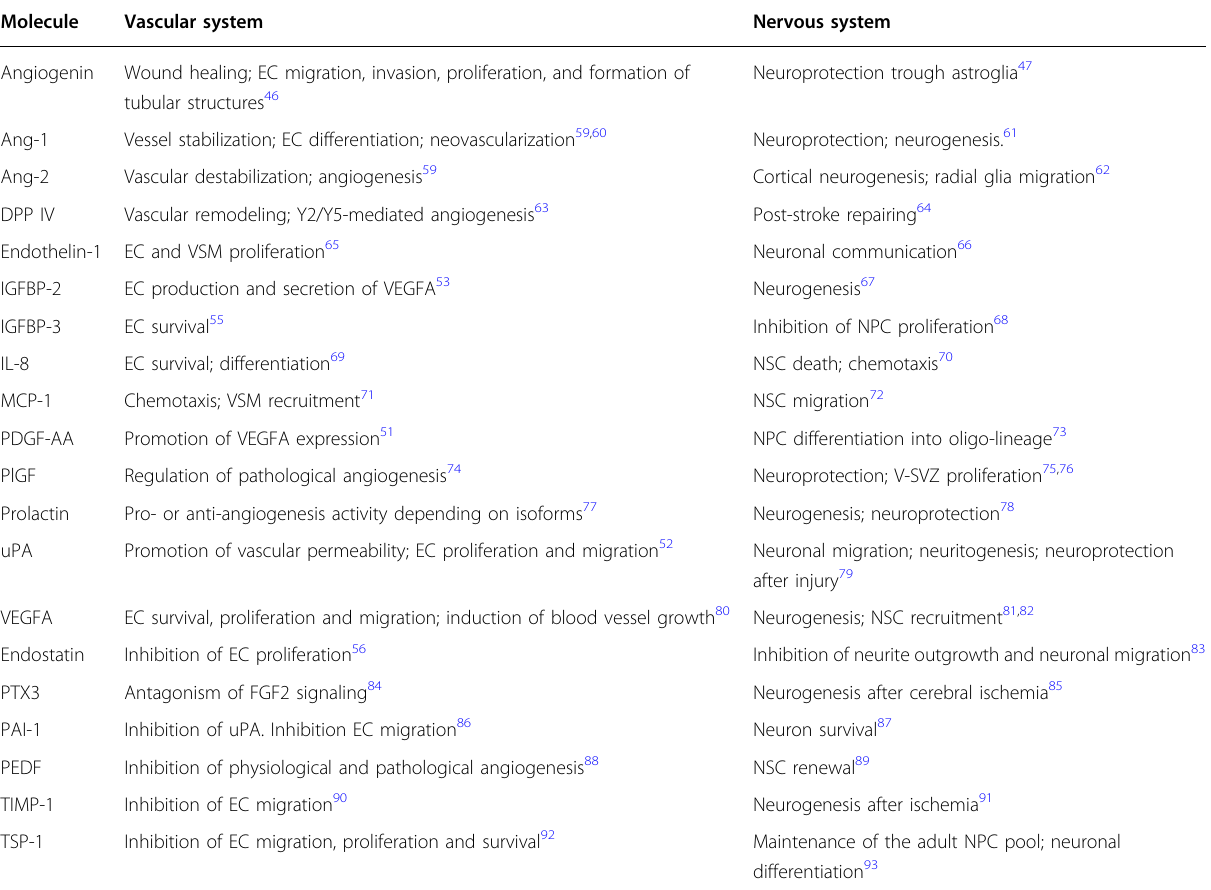
Table 1 Dual role of angiogenic molecules secreted by Ctrl hiPSC derived NSC Molecule Vascular system Nervous